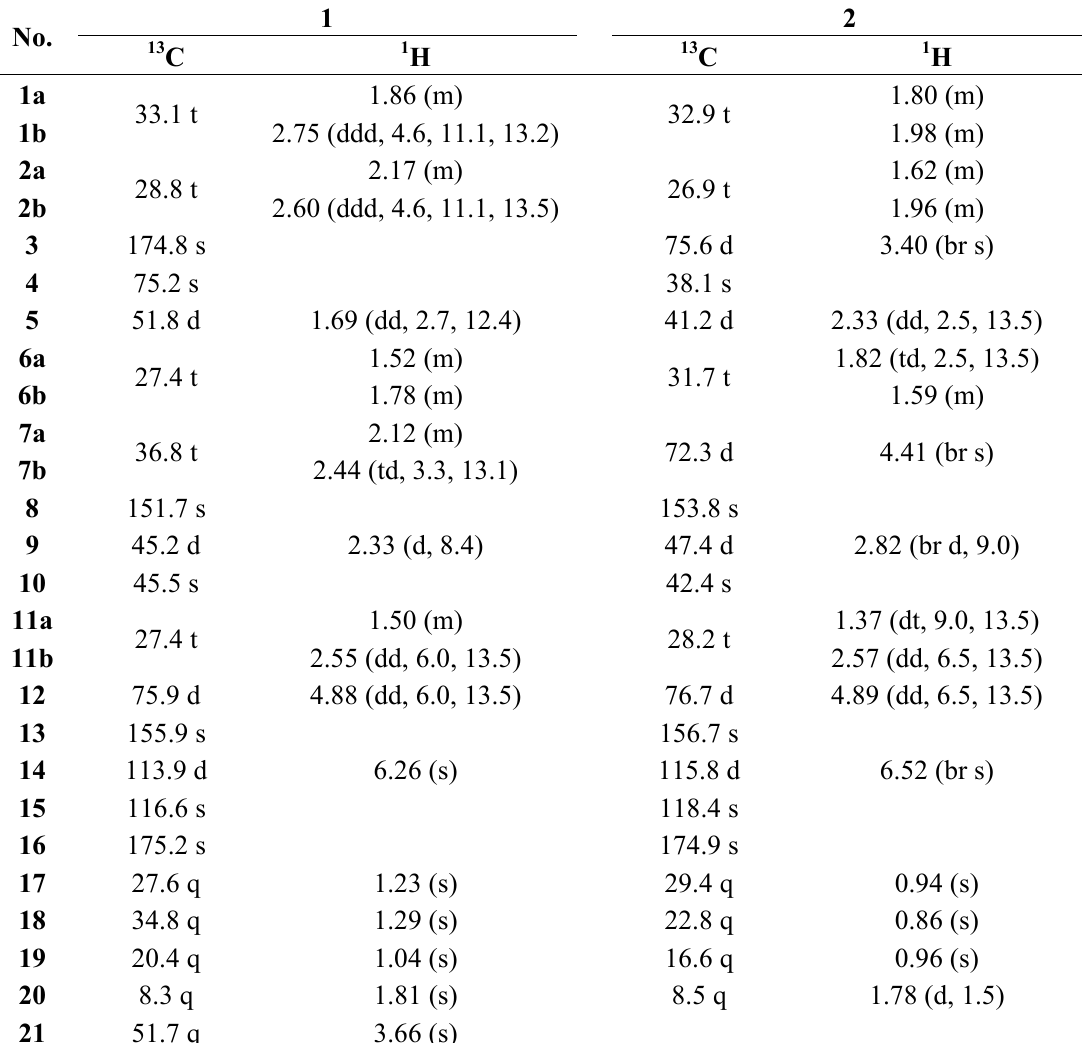
, 500 MHz,  in ppm (mult., J in 3